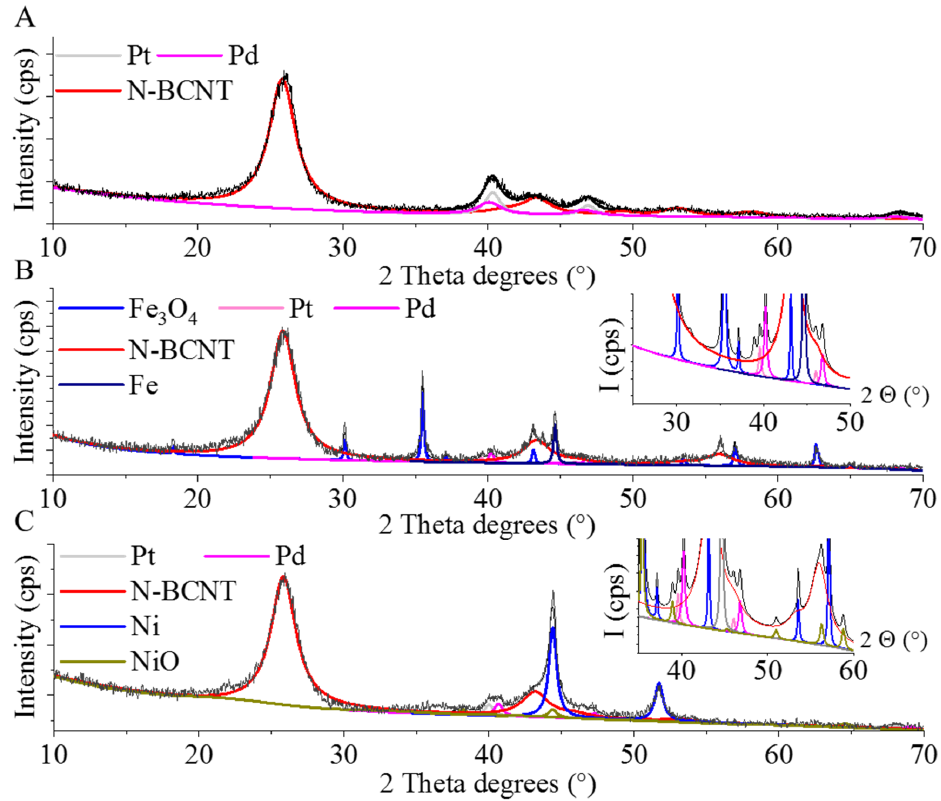
Figure 6. XRD patterns of the palladium and platinum decorated calcium (Pd-Pt/GCNC) ( A ), magnetite (Pd-Pt/Fe-GCNC) ( B ), and nickel (Pd-Pt/Ni-GCNC) ( C ) containing granulated carbon Table 1. Specific surface area of the developed granulated carbon nanocomposite supported Pd-Pt decorated catalysts before and after using them 5 times.